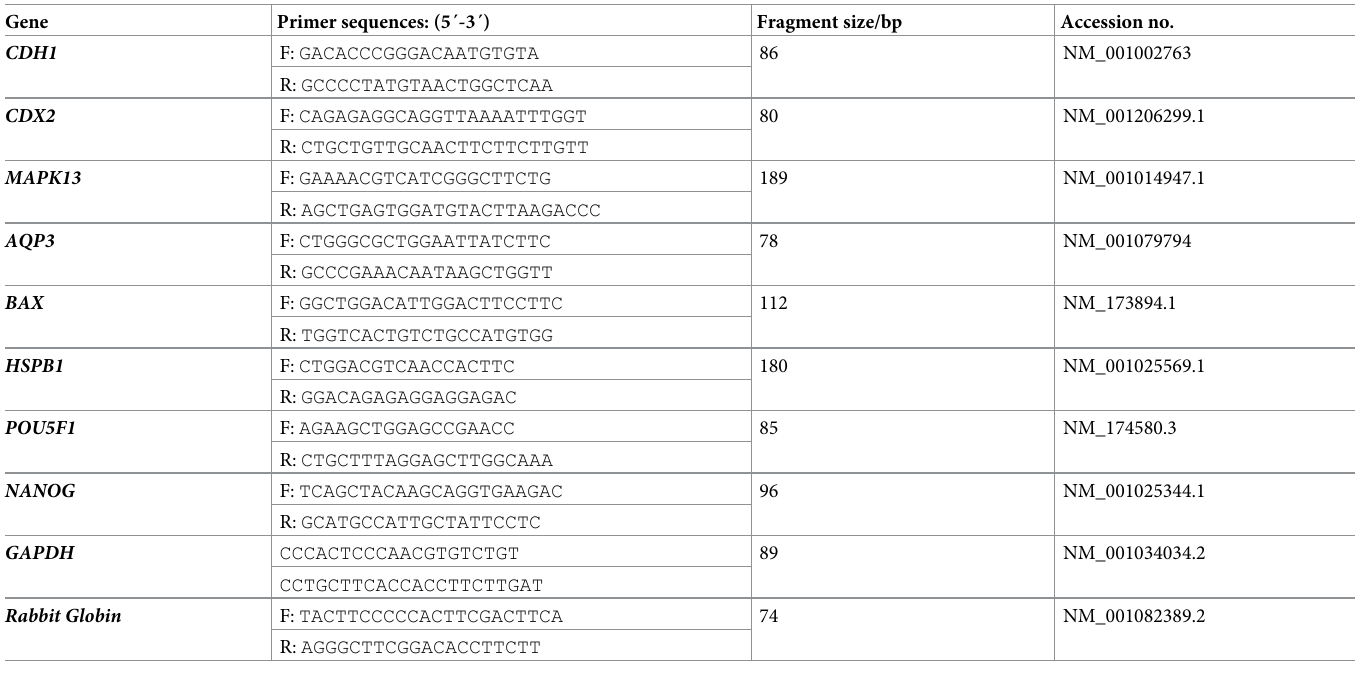
Regulator ( BAX ), and Heat shock protein beta-1 ( HSPB1 ), and the pluripotent POU domain, class 5, transcription factor 1 ( POU5F1 ), and the Nanog Homeobox ( NANOG ) was performed using the primers listed in Table 1 . To RNA preparation, Poly(A)+ RNA was isolated using the Dynabeads 1 mRNA Direct Kit (Life Technologies) according to the manufacturer’s instruction with some modifications. Briefly, pools of three expanded blastocysts from each experimental group (Control: n : 6, Sham-Control: n : 9, MT-Sperm: n : 7, MT-Co-incubation: n : 7; each was considered as RT- qPCR replicate) derived from six replicates of IVP cycles were thawed in 40 μ l of lysis-binding DTT). Then 3.0 pg rabbit globin mRNA was added as external standard and incubated at room temperature for 10 minutes. Poly(A)+ RNA was isolated using the Dynabeads 1 mRNA Table 1. Primers sequences used for the real-time qPCR.